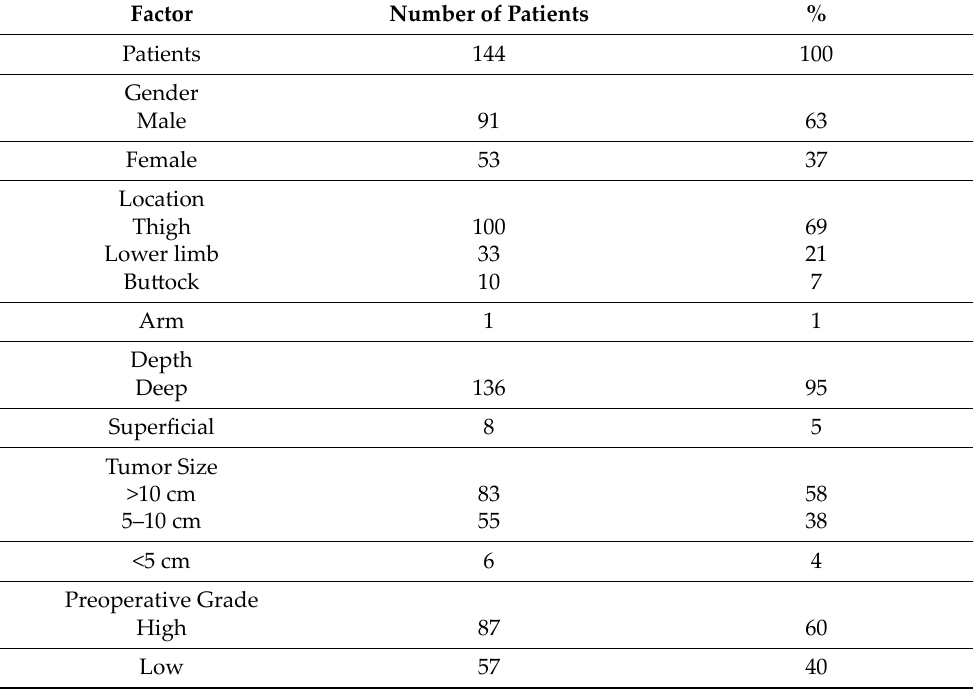
Table 1. Main Clinicopathological Features and Therapeutic